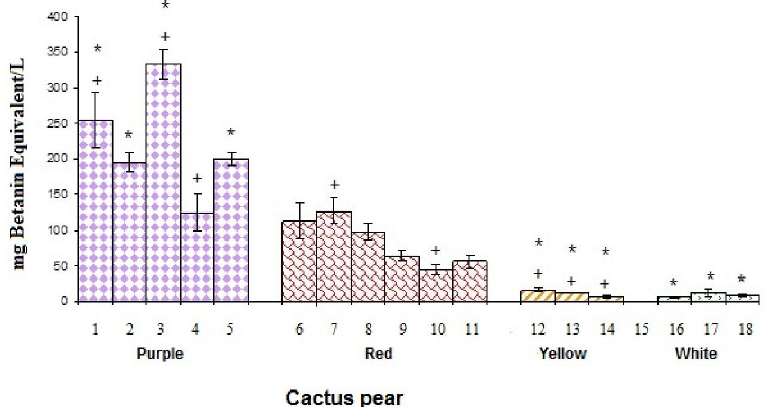
Figure 1. Betacyanin content of cactus pear studied cultivars. * denotes statistical significance at p < 0.05 among all studied cultivars of cactus pears. + indicates statistical significance at p < 0.05 among the cultivars of cactus pears in the same